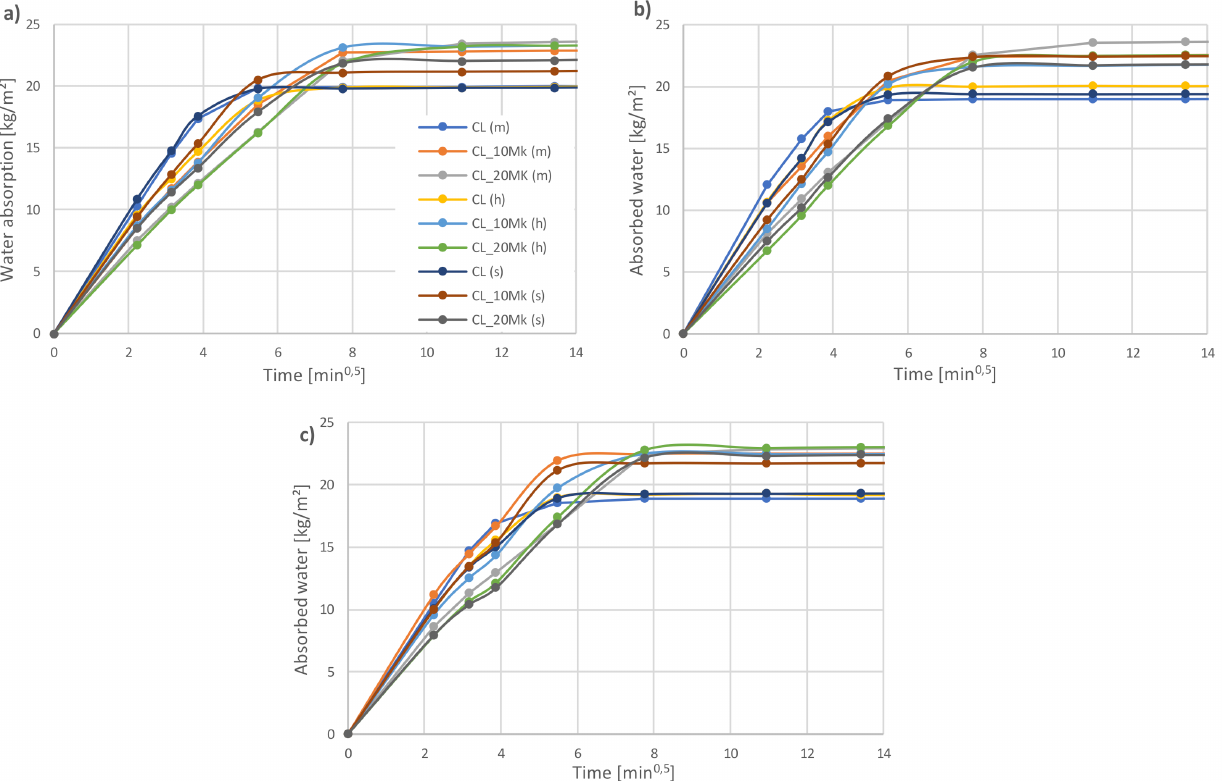
Figure 9. The Capillary curves of mortars with 0, 10 and 20% Mk replacing air lime, after ( a ) 28 days; ( b ) 90 days; ( c ) 180 days in maritime, humid and standard curing